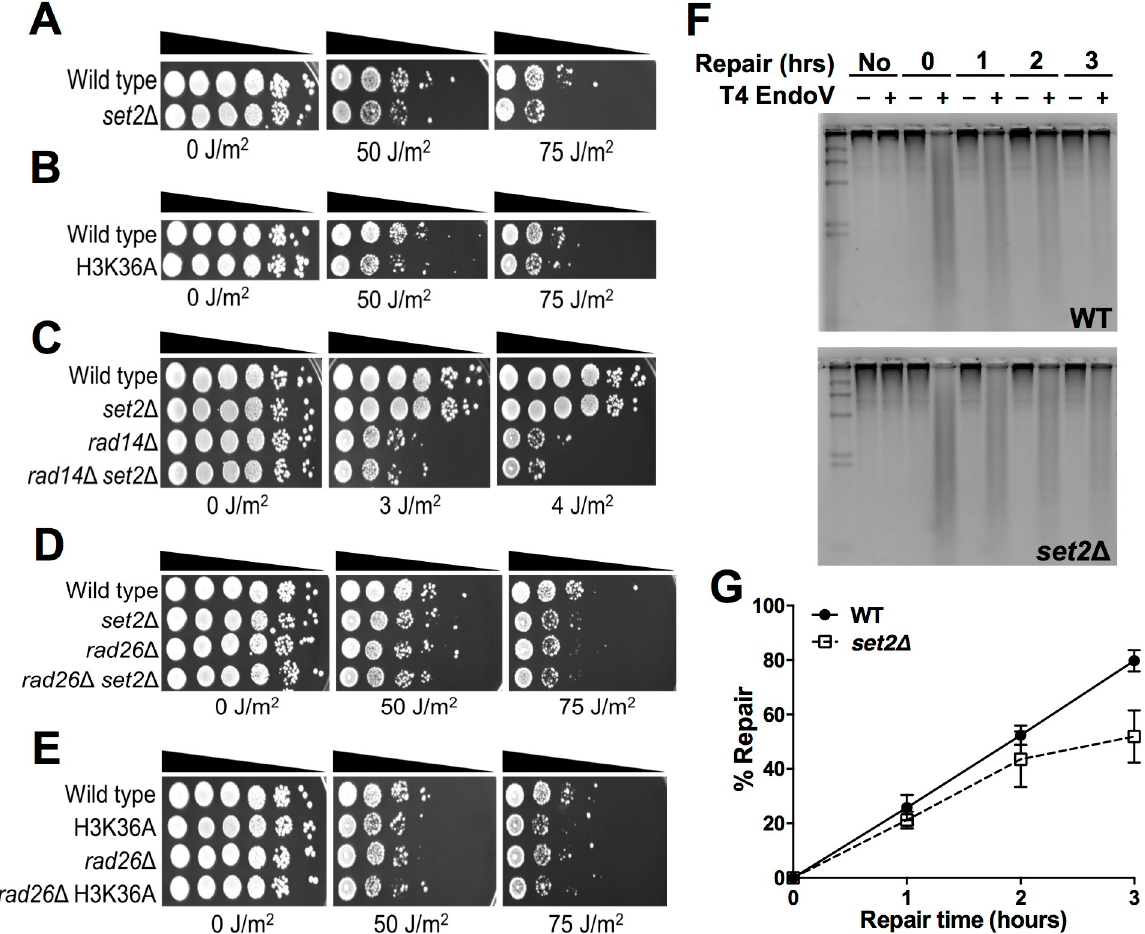
Fig 1. Mutation of SET2 or H3K36 causes UV sensitivity that is epistatic with RAD26 . (A-E) Indicated mutant yeast strains were serially 10-fold diluted, spotted on YPD plates, and exposed to the specified doses of UVC light. (F) Representative alkaline gel of bulk repair of UV- induced CPD lesions in WT and set2 Δ mutant yeast cells. Genomic DNA was isolated at the indicated time following damage induction with 100 J/m 2 UVC light and treated with or without (+/ − ) T4 endonuclease V and run on the alkaline gel electrophoresis. (G) Quantification of CPD repair in WT and set2 Δ cells based on alkaline gel analysis plotted as the mean ± SEM of three replicate experiments. Source data is in S1 Data.